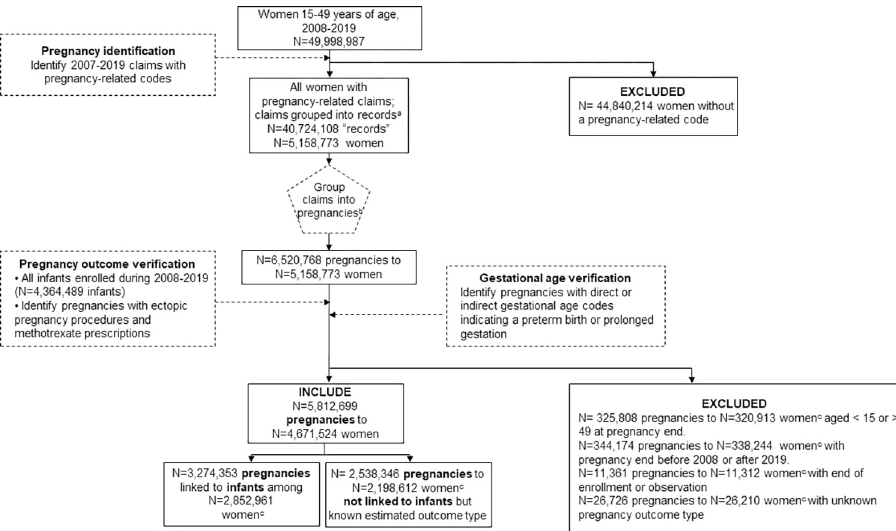
Fig 2. Identification of cohort of pregnant women, MarketScan commercial data, 2008–2019. a Extracted and then deduplicated inpatient, outpatient, and facility header claims with codes from S2 into pregnancy-related ‘records’: distinct combinations of service dates and pregnancy-related codes (diagnosis, procedure, or diagnosis related group). b Records likely belonging to the same pregnancy were grouped together into pregnancy episodes. c Because women could have more than one pregnancy, the sum of these categories will be greater than the total number of